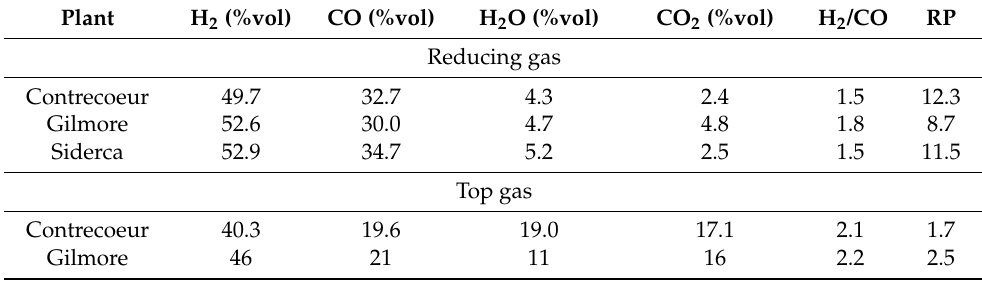
Table 1. Characteristics of the reducing gas and top-gas for the three NG-DR reference plants [31,32].